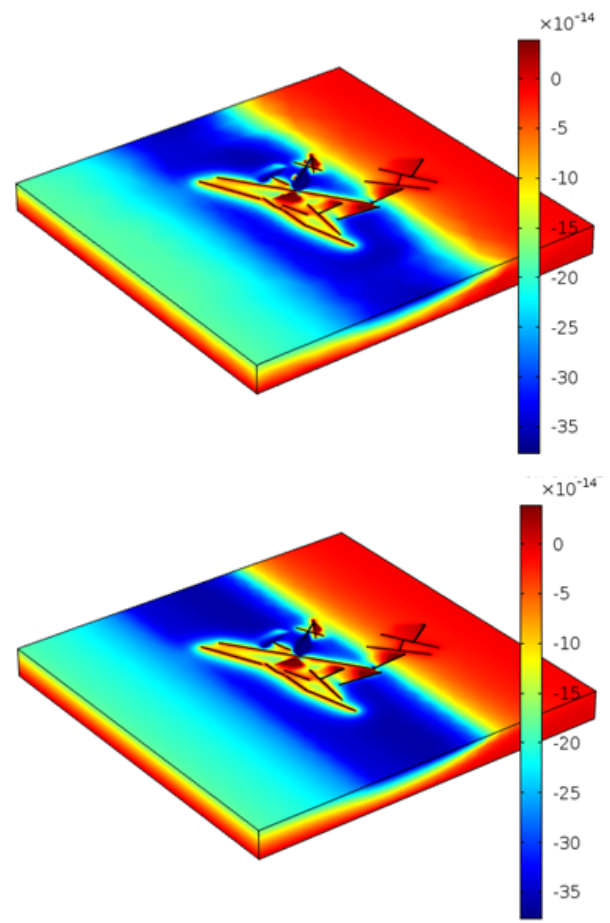
Figure 5. Vertical fluid velocity [ms − 1 ] in the intact part of the fractured rock for “Custom” mesh (top) and “Extra Fine” mesh (bot- tom). Time is 5900 years and glacier velocity is 1.27myear − 1 . The velocity is obtained by solving a pure hydraulic